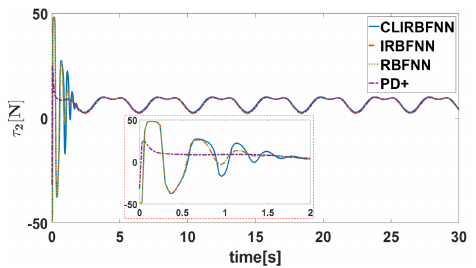
Figure 9. The torque of Joint